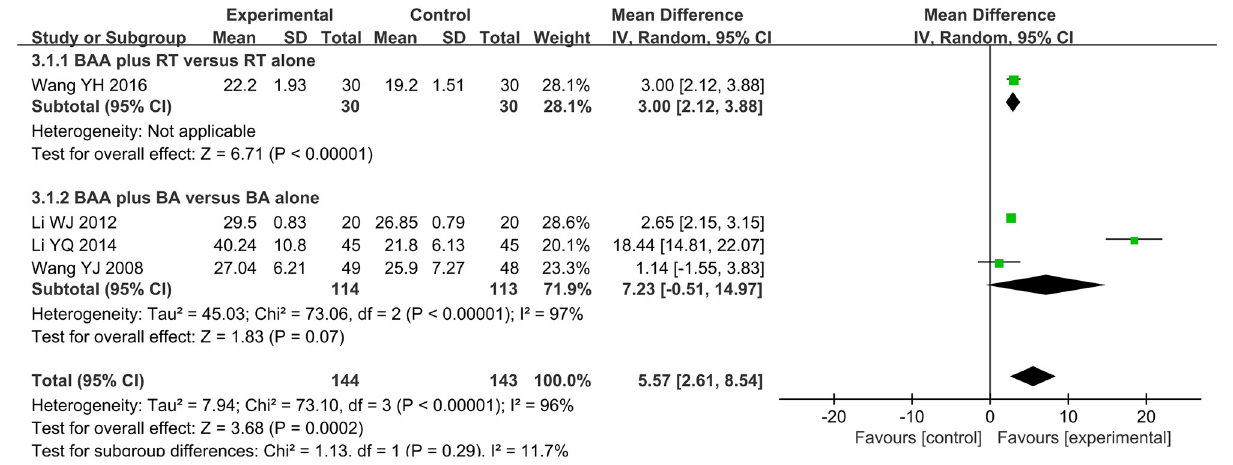
FIGURE 5 | Forest plot and meta-analysis of FMA-L. (BA, body acupuncture; BAA, Bo’s abdominal acupuncture; CI, confidence interval; FMA-L, Fugel-Meyer Assessment Scale for lower extremity; RT, rehabilitation training).